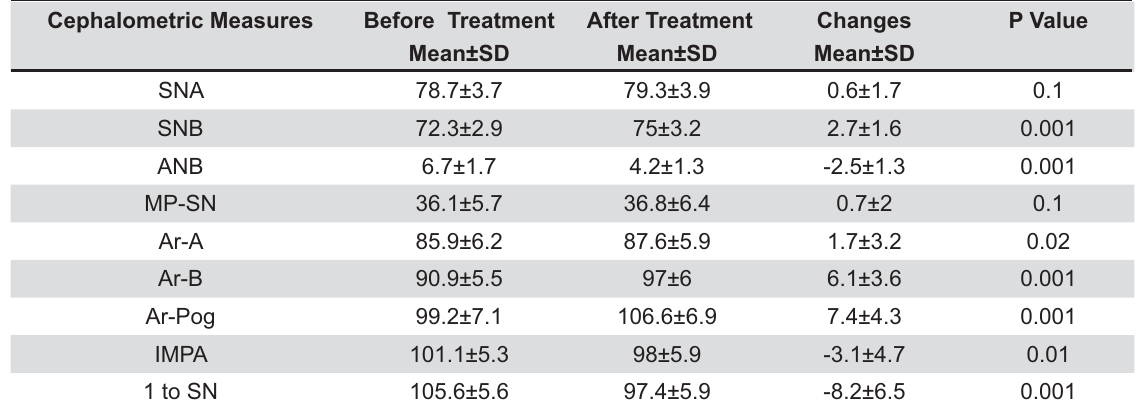
Table 1- Pretreatment and post treatment measurements of R-appliance group Cephalometric Measures